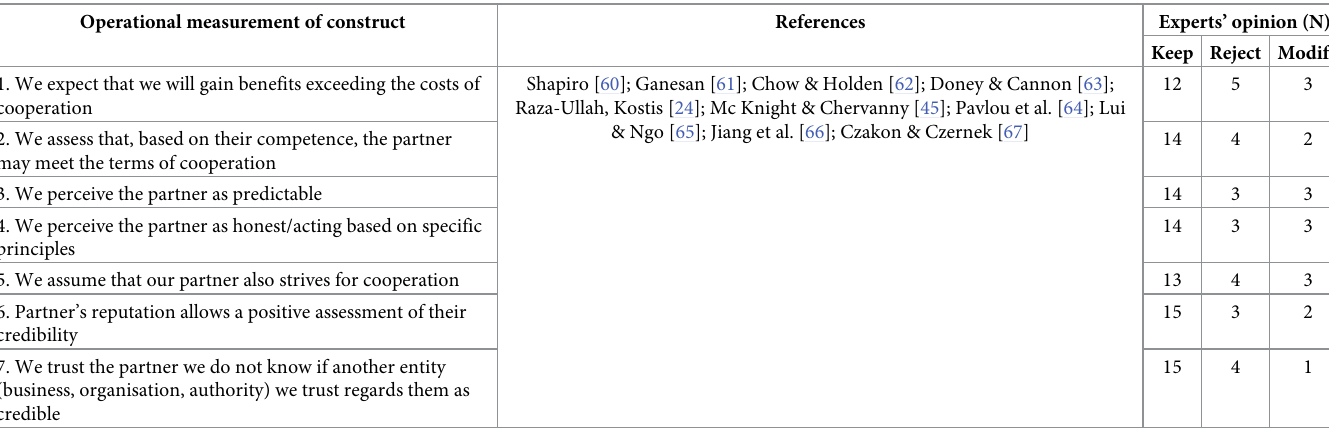
Table 2. Operationalisation of the construct of mechanisms of building trust in partners as a latent